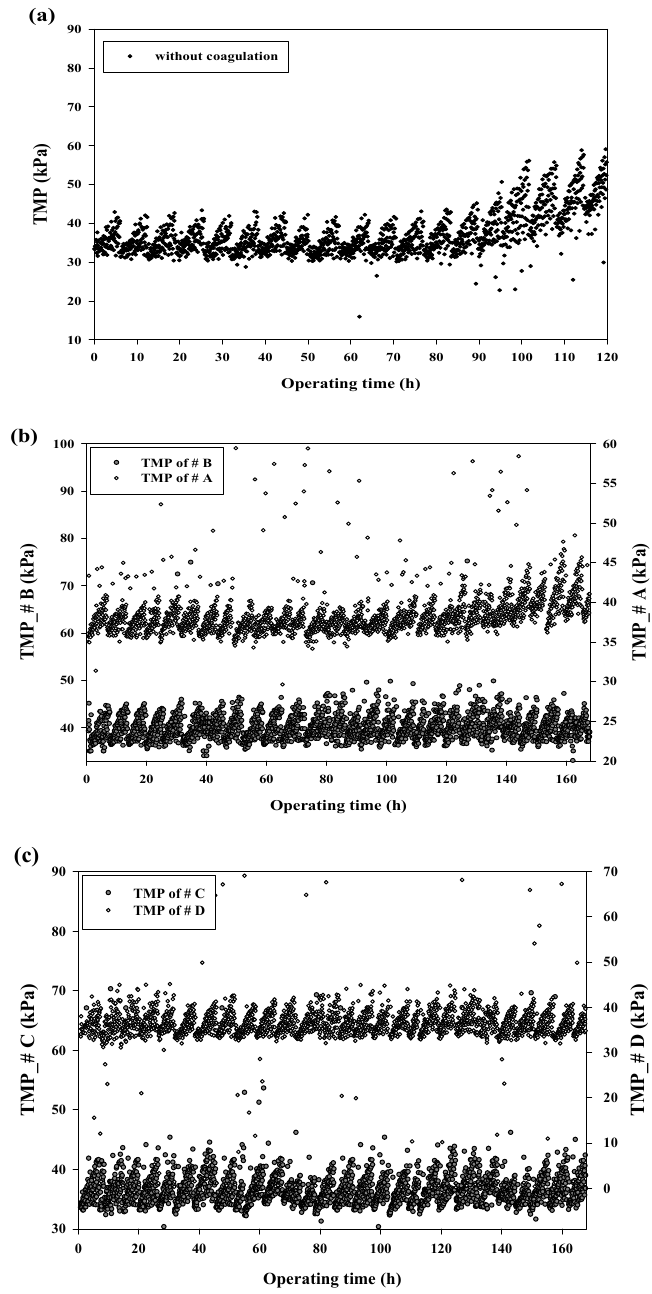
Figure 4. Changes in TMP-based on increase in operating time under each coagulation condition during the in-line coagulation/UF process: ( a ) raw water; ( b ) Conditions A and B; ( c ) C and